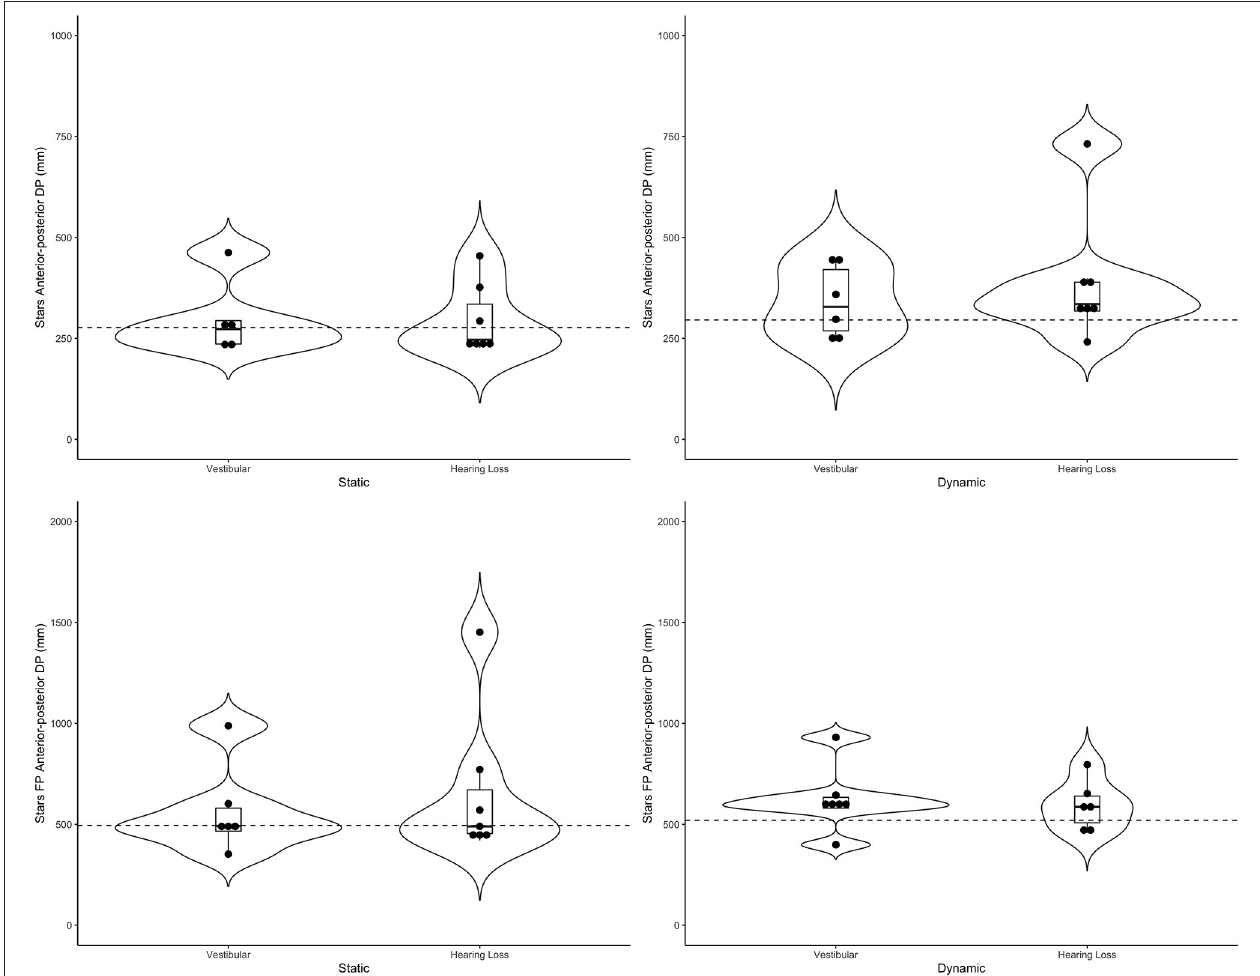
FIGURE 5 | Violin plots representing the distribution of both clinical groups around the mean of the control group (represented by the dashed line) for the stars scene in the anterior-posterior direction. Top plots show head data and bottom plots represent postural sway data (FP = forceplate). Left-hand side represents the static scenes and right-hand side represents the dynamic